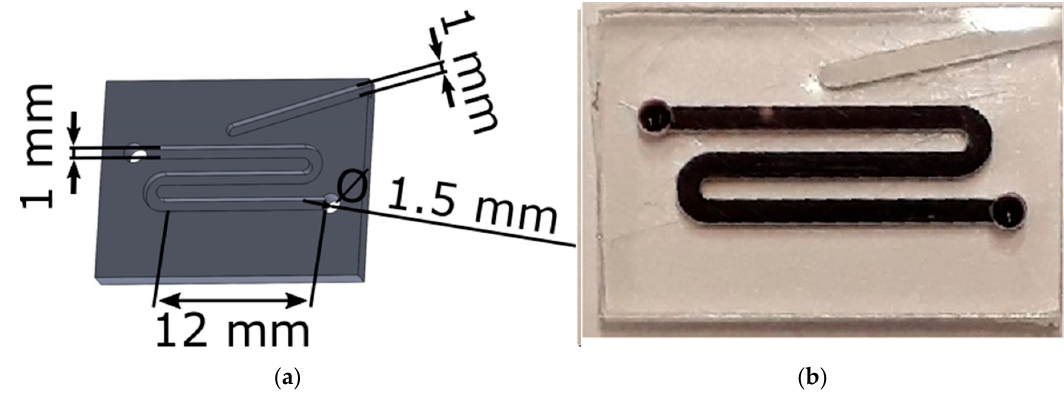
Figure 3. Multiple displacement amplification (MDA) chips with ( a ) the schematic representation of the MDA chips with the used dimensions and ( b ) a chip filled with food dye to show the channel design.